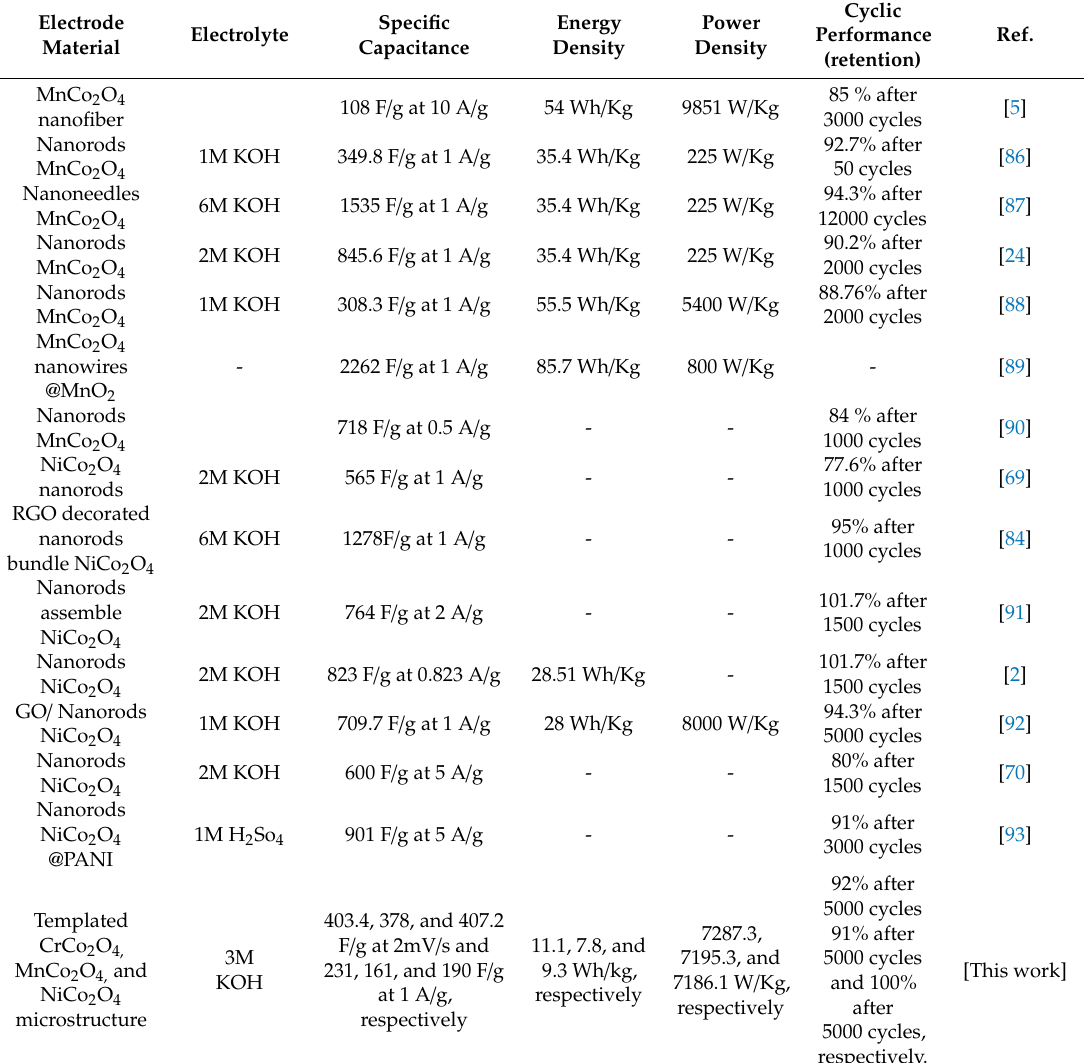
Figure 7. ( a ) Comparison of specific capacitance as a function of current density and ( b ) Ragone plot of power density vs. energy density. Table 4. Comparison of electrochemical performance of MCo 2 O 4 (M = Cr, Mn, Ni) as available from the literature.